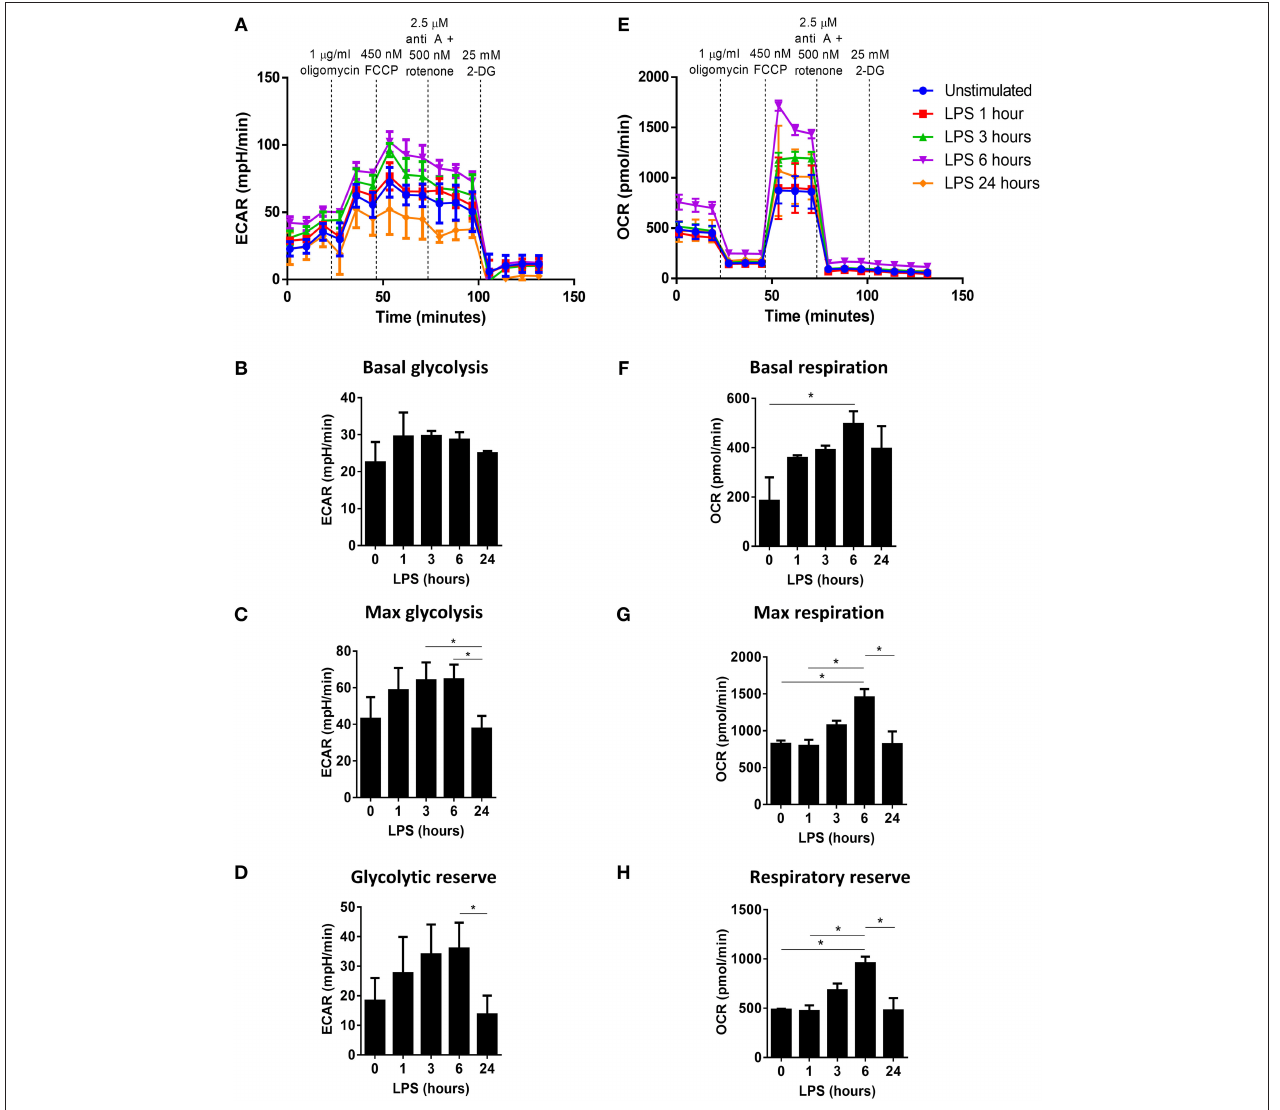
FIGURE 1 | Determination of the changes in glycolytic metabolism and oxidative phosphorylation over time in LPS-stimulated human DC. Primary human DC ( n = 3) were stimulated with LPS (100ng/ml) for 1, 3, 6, or 24h prior to placement in a Seahorse XF24 analyser. The extracellular acidification rate (ECAR) and oxygen consumption rate (OCR) were measured before and after the addition of oligomycin (1 µ g/ml), FCCP (450nM), antimycin A (2.5 µ M), and rotenone (500nM), and 2-DG (25mM). (A) ECAR measurements over time for each LPS stimulation time-point. Data depicts one representative experiment. Pooled data ( n = 3) depicts the calculated mean ( ± SEM) (B) basal glycolytic rate, (C) max glycolytic rate, and (D) glycolytic reserve for each LPS stimulation time-point. (E) OCR measurements over time for each LPS stimulation time-point. Data depicts one representative experiment. Pooled data ( n = 3) depicts the calculated mean ( ± SEM) (F) basal respiratory rate, (G) max respiratory rate, and (H) respiratory reserve for each LPS stimulation time-point. Statistical significance was determined by repeated measures one-way ANOVA with Tukey’s multiple comparisons post hoc test to compare the means of all treatment groups (* p <